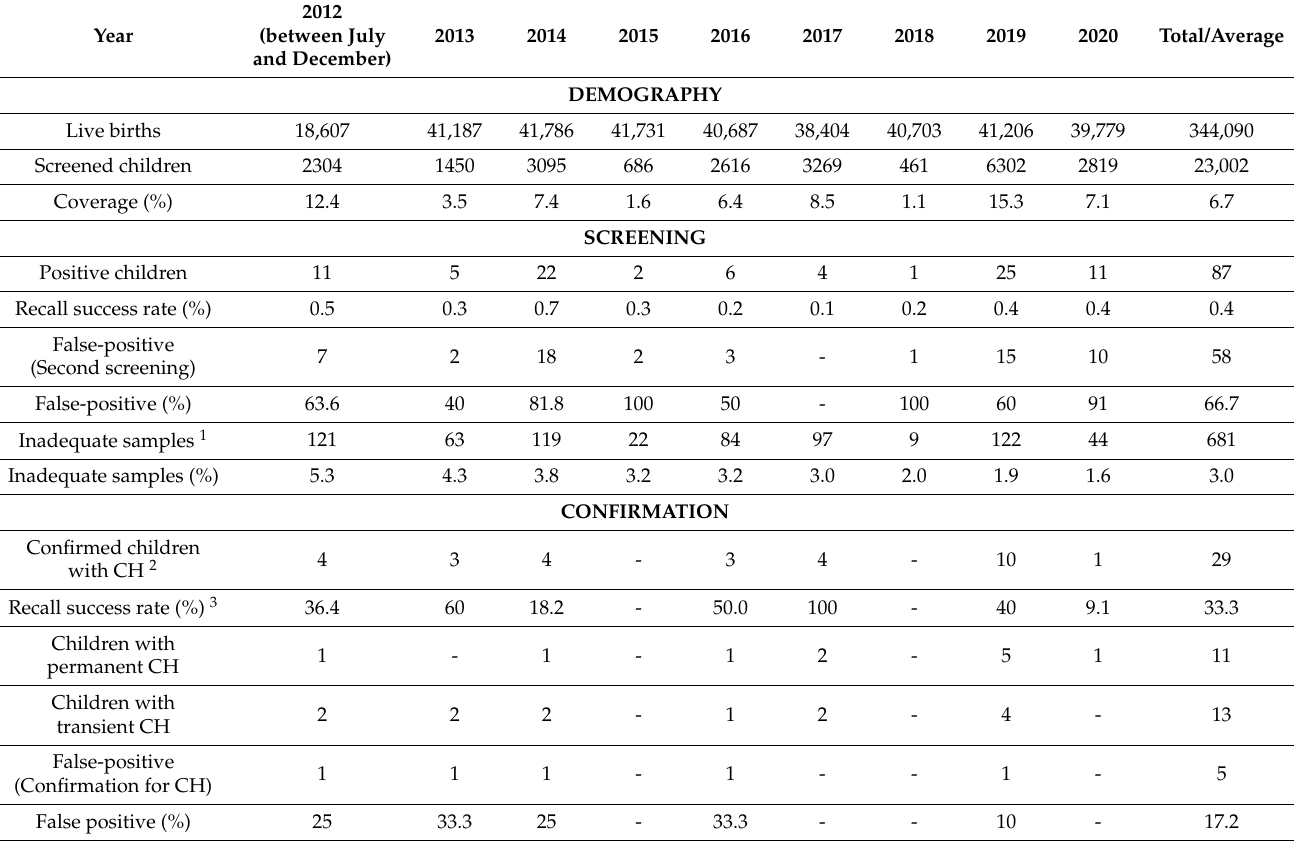
Table 1. Characteristics and results of the NBS for CH in Ulaanbaatar (2012 to